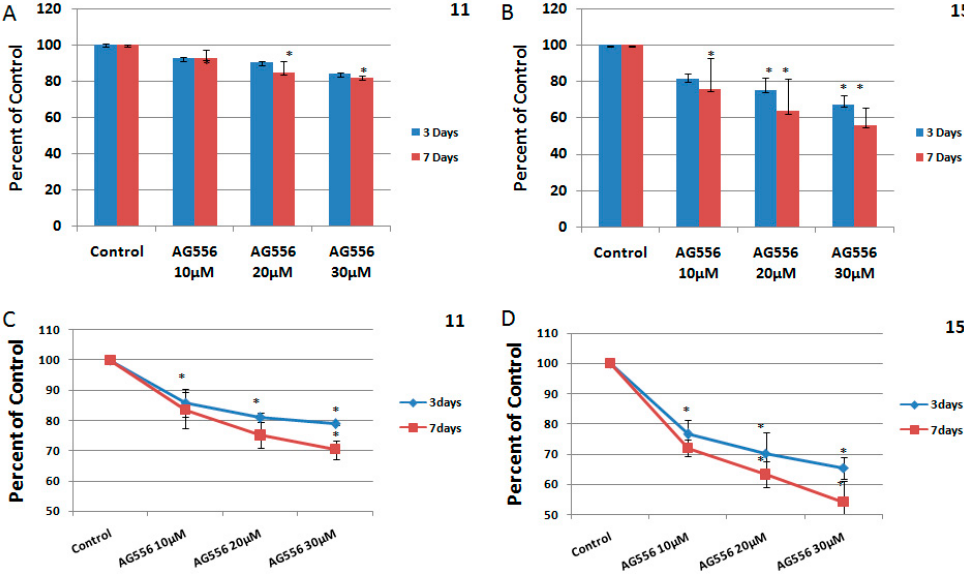
Figure 3. The effect of EGFR inactivation by AG556 on HGG cells. The 11 HGG ( A , C ) and 15 HGG ( B , D ) cells were seeded in 96-well culture plates or in 12-well culture plates and treated with 10 μ M, 20 μ M or 30 μ M AG556. The cells were incubated for three or seven days and cell viability was determined by 3-(4,5-dimethylthiazol-2-yl)-2,5-diphenyl tetrazolium bromide (MTT) assay and by a Trypan Blue Exclusion Test. All results show the mean of three independent experiments ± SD, * p < 0.05 vs. untreated cells.